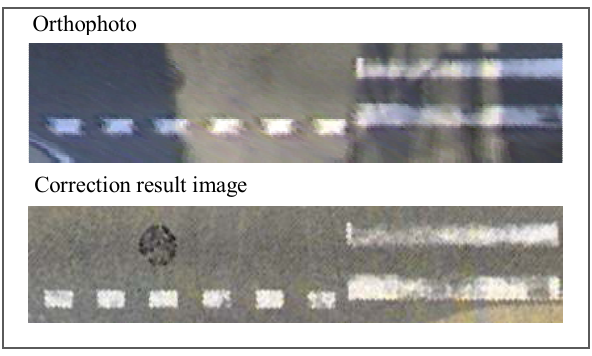
Figure 17. Comparison of visibility at the edge of images